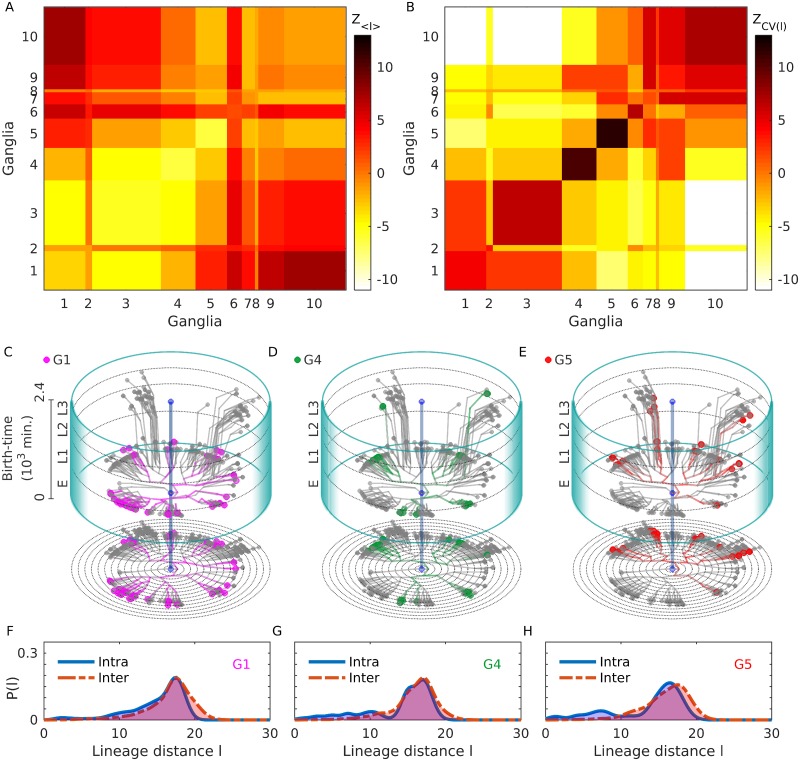
Lineage distance reveals developmental patterns of ganglia.(A-B) Statistically significant features of the distribution of intra and inter-ganglionic lineage distances, quantified by deviations of the mean 〈l〉 (A) and coefficient of variation CV (B), from a surrogate ensemble of randomized lineage trees of neurons in the C. elegans somatic nervous system. These deviations (measured by z-score) show that the mean intra-ganglionic lineage distances (represented by diagonal blocks of the matrix) are significantly lower than that of the inter-ganglionic lineage distances (off-diagonal blocks), with the exception of G6 and G9. By contrast, CV for the intra-ganglionic lineage distances are significantly higher than that of the inter-ganglionic lineage distances. (C-E) Developmental chrono-dendrograms for three representative ganglia (viz., G1, G4 and G5) show that each comprises multiple localized clusters of neurons occurring at different locations on the developmental lineage tree, explaining the statistically significant deviations of the mean and CV for intra-ganglionic lineage distances. Colored nodes represent neurons belonging to the specified ganglion while gray nodes show the other neurons. Branching lines trace all cell divisions starting from the single cell zygote (located at the origin) and terminating at each differentiated neuron. The time and rung of each cell division are indicated by its position along the vertical and radial axis respectively. The entire time period is divided into four stages, viz., Embryo (indicated as E), L1, L2 and L3. A planar projection at the base of each cylinder shows the rung (concentric circles) of each progenitor cell and differentiated neuron. (F-H) The probability distribution functions for the intra-ganglionic lineage distances show bimodality (unlike that of the inter-ganglionic distances), which is consistent with the segregation of a ganglion into multiple clusters along the chrono-dendrogram. The different ganglia are indicated by symbols G1-G9 (1: Anterior, 2: Dorsal, 3: Lateral, 4: Ventral, 5: Retrovesicular, 6: Posterolateral, 7: Preanal, 8: Dorsorectal and 9: Lumbar) and the Ventral cord as G10.